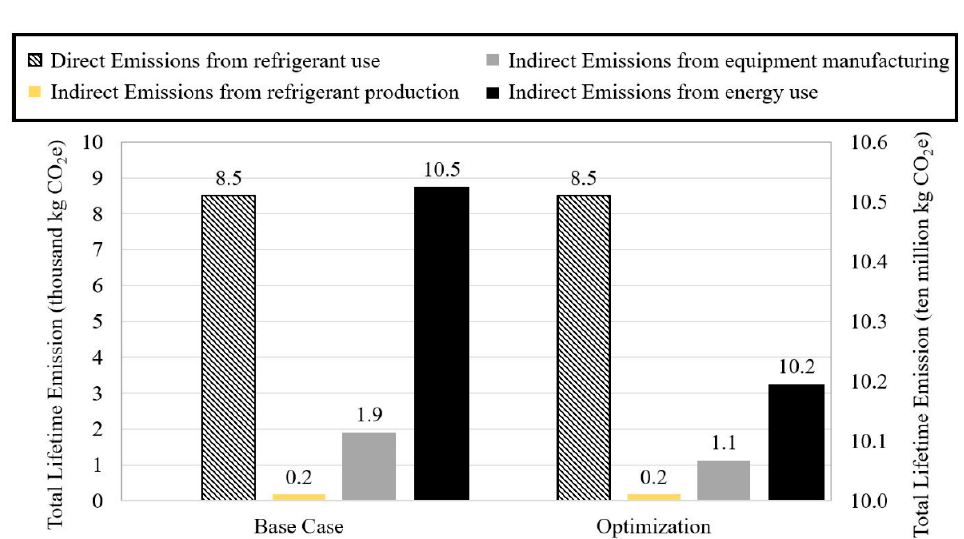
Figure 11. Result of economic analysis; ( a ) comparison of economic feasibility between the existing design method and the optimized design method for initial investment cost, energy cost, and total cost. ( b ) LCC comparison analysis result between the existing design method and the optimized